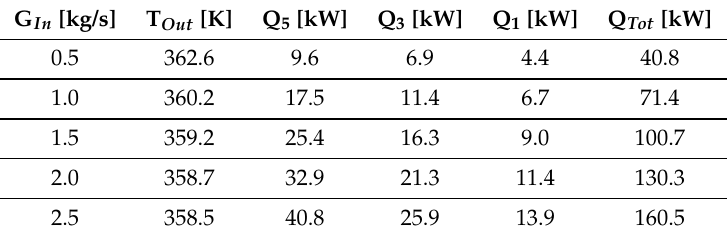
Figure 7. Outflow temperature and transferred heat flux for the single-inlet geometry. ( a ) Mass-averaged outflow temperature as a function of G In for T Cyls = 440 K. ( b ) Cylinder specific and total transferred heat flux as a function of G In for T Cyls = 440 K. ( c ) Mass-averaged outflow temperature as a function of G In for T Cyls = 400, 420, 440, and 460 K. ( d ) Total transferred heat flux as a function of G In for T Cyls = 400, 420, 440, and 460 K. Table 1. Mass-averaged temperature, cylinder-specific and total transferred heat flux for T Cyls = 440 K and G In = 0.5, 1.0, 1.5, 2.0, and 2.5 kg/s obtained considering the single-inlet geometry.